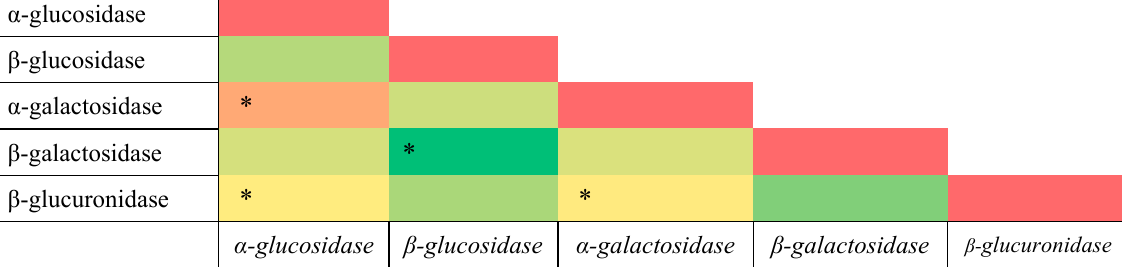
Figure 7. Pearson’s heatmap representing correlation between the activity of fecal enzymes. Green represents negative correlation, whereas orange and red represent positive correlation. *: ( p < 0.05). In most cases, the outcomes produced may be rationalized by the fact that, due to the BMI disparity, differences in diet and the ratio of probiotic bacteria to less desired genera, the concentrations and/or activity of different metabolites are influenced, favoring either the beneficial or potentially harmful ones. The pH in the large intestine also changes,